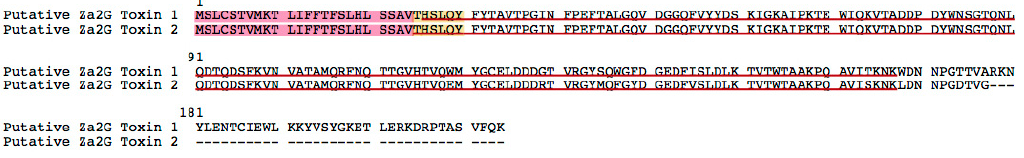
Figure 8. The putative Za2G toxin sequences from Chinese yellow catfish. Sequences in red background are signal peptides. Peptides in yellow background are verified by LC-MS/MS analysis. The red underlined domain are highly homologous to the MHC_I superfamily. Dashed lines means the absence of corresponding amino acid sequences.